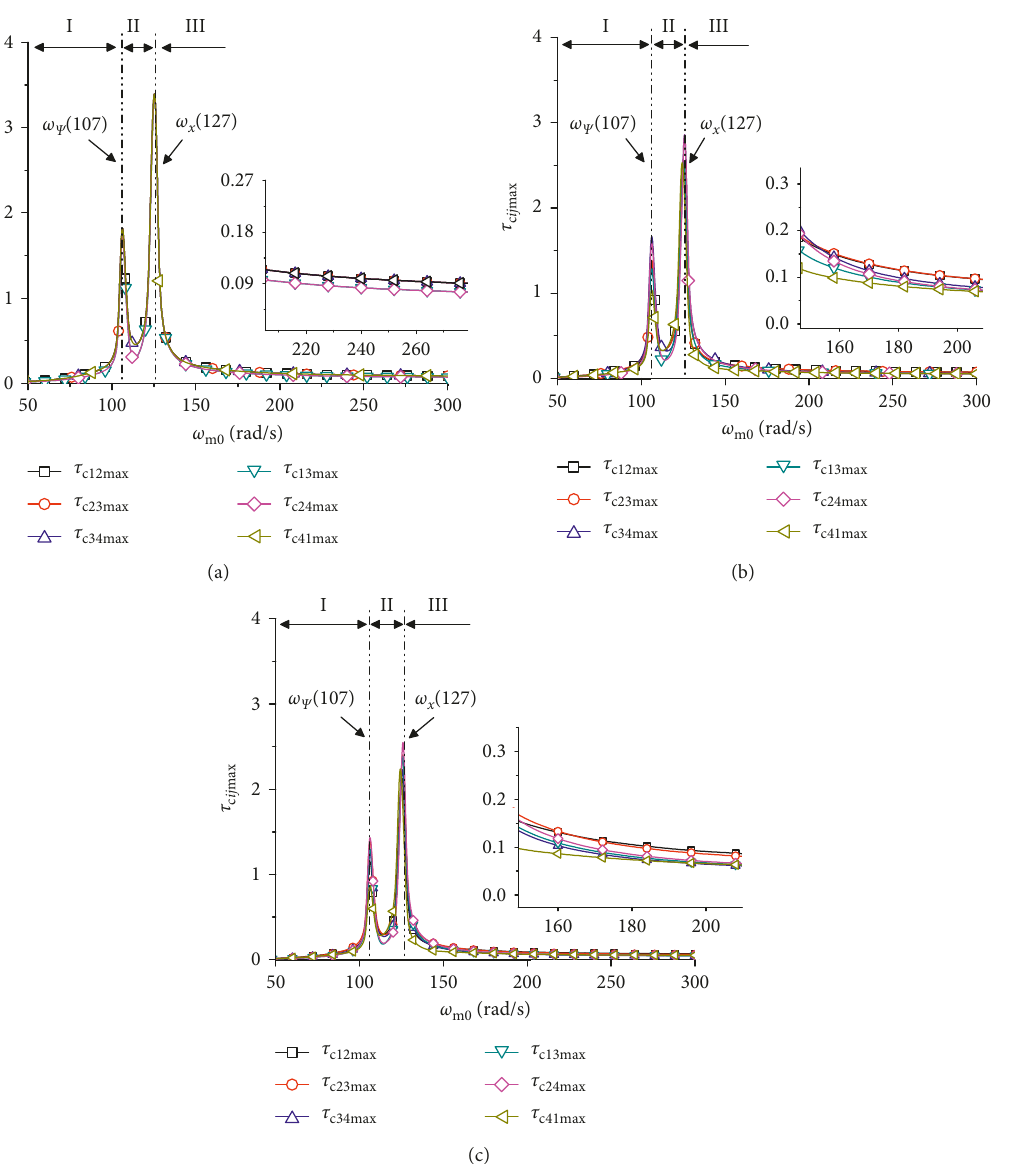
i 1 , 2 , 3 , 4 (cid:31)